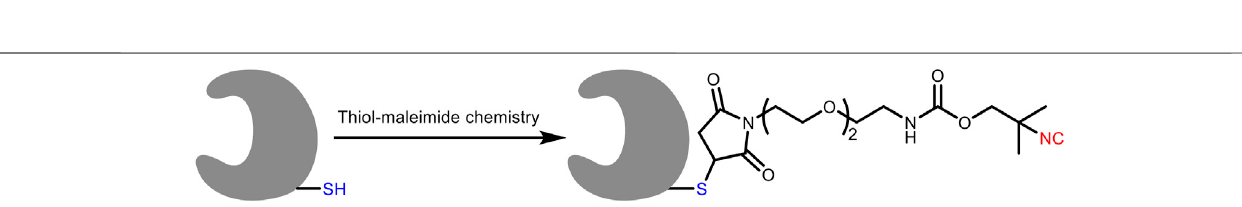
FIGURE 10 | An isocyano-containing linker tagged to the protein through cysteine